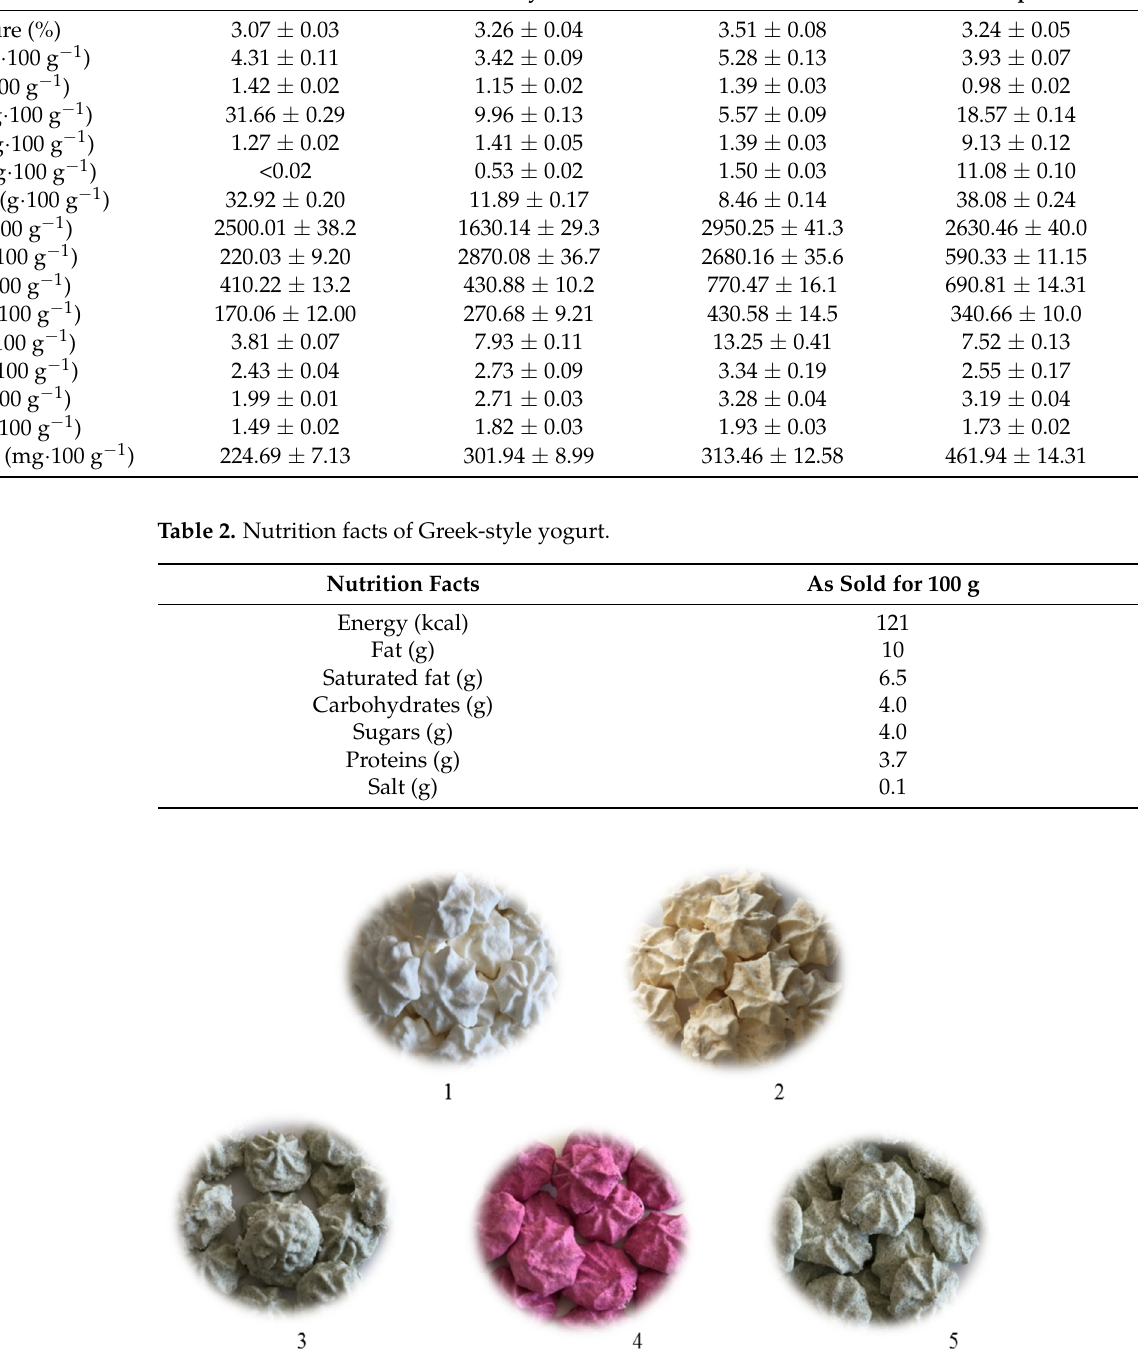
Figure 1. Yogurt bites: yogurt bites without plant raw materials (control) ( 1 ); yogurt bites with